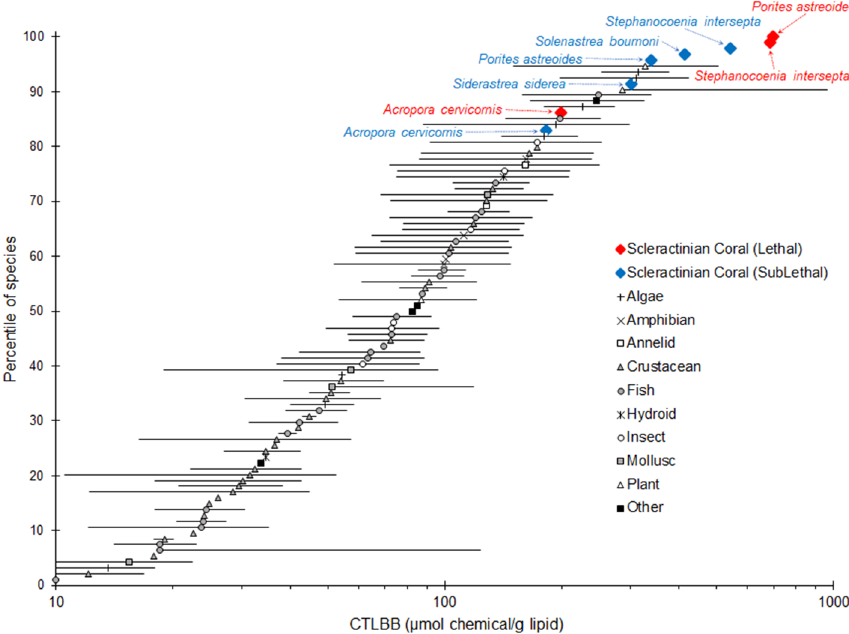
Figure 7. Comparison of critical target lipid body burdens (CTLBBs) (µmol chemical/g lipid) of 94 taxa, including freshwater, brackish, and marine species 18,34,35